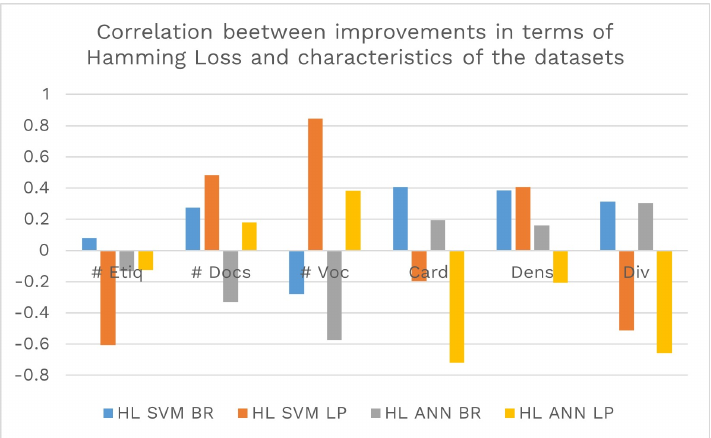
Figure 5. Correlation between performance improvements in terms of Hamming Loss and the different characteristics of the data set (number of labels, number of documents, number of vocabulary terms, cardinality, density, and diversity).